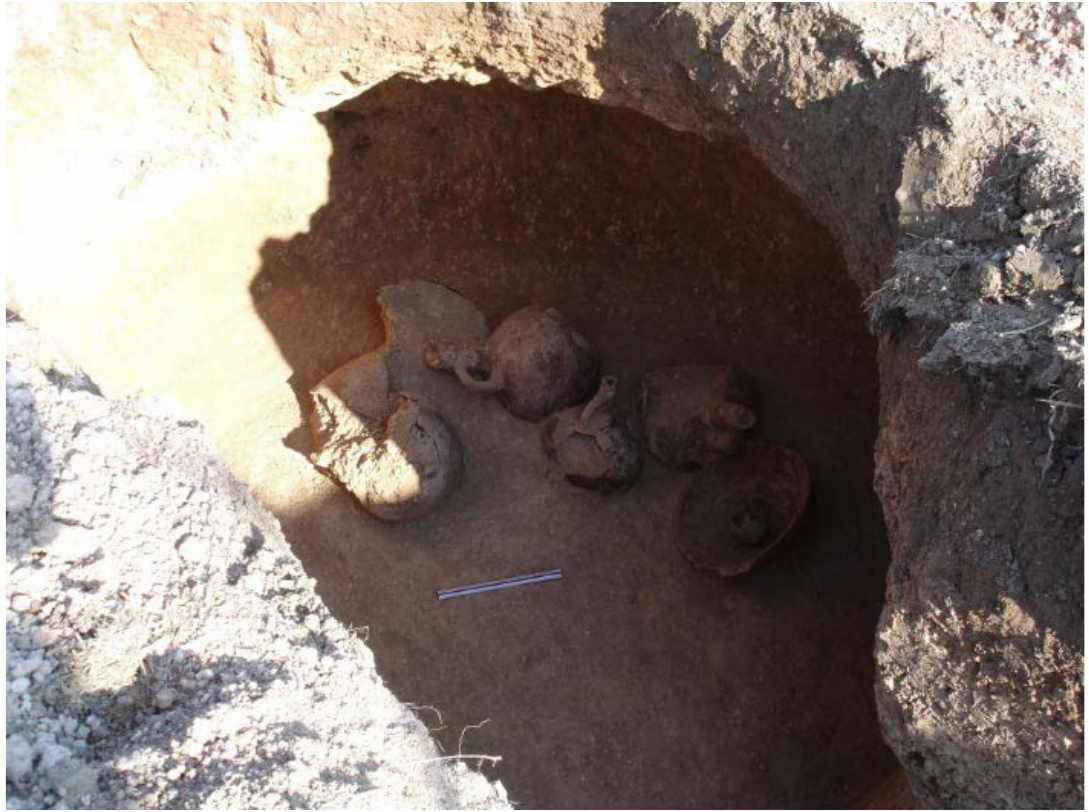
Figure 7. Early Bronze Age tomb, excavated by the Department of Antiquities, Republic of Cyprus (Image by Anna Satraki).